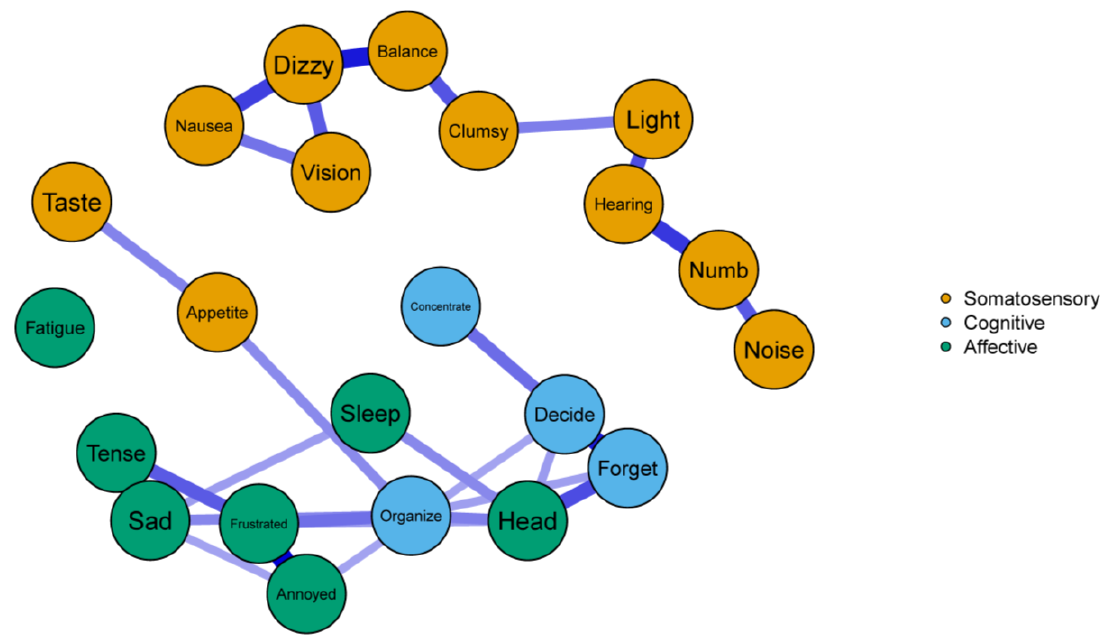
Figure 3. The COVID − network. Solid edges indicate positive associations with width and depth of color indicating the strength of associations.